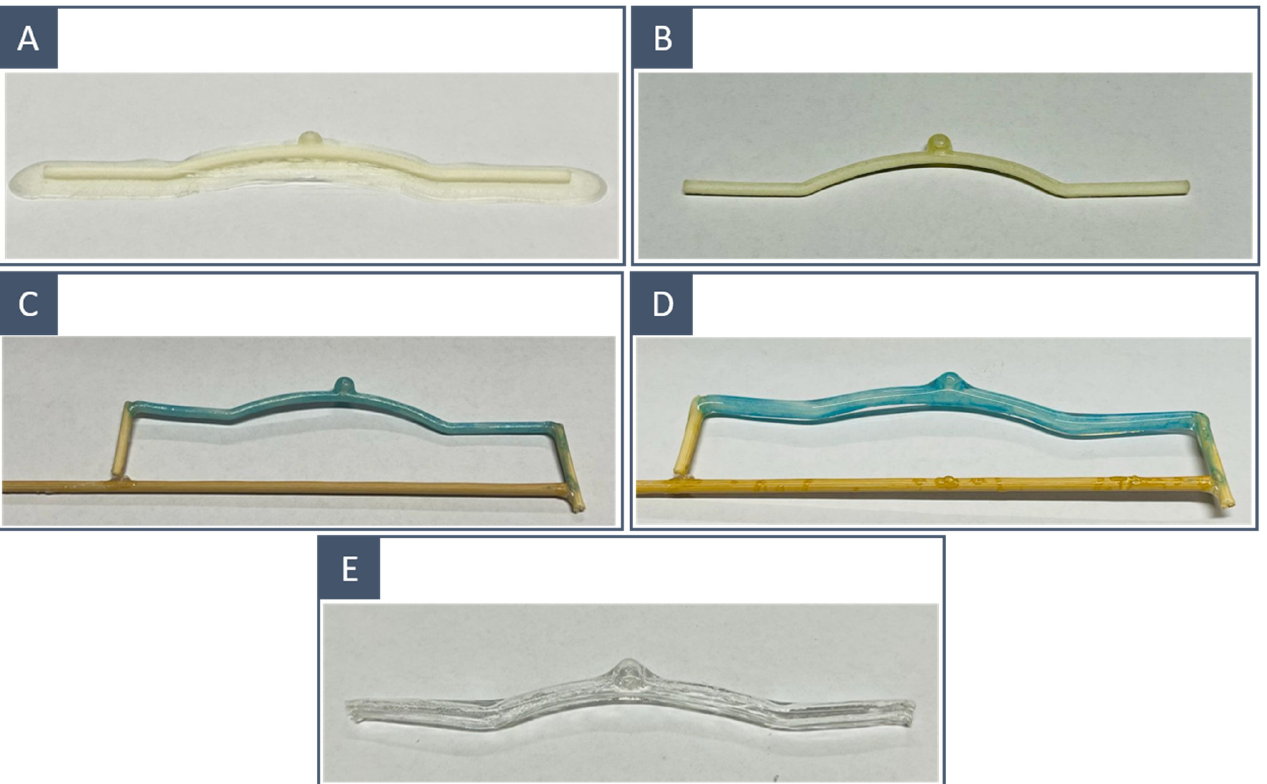
Figure 4. Manufacturing process: ( A ) FDM-printed model with supports, ( B ) after supports removal and surface polishing, ( C ) painting with the liquified PVA-based filament and water-soluble resin solution and fixing on a straight stick, ( D ) after solidification of the silicone layer and ( E ) after dissolution. The same workflow was carried out on SLA-printed models.